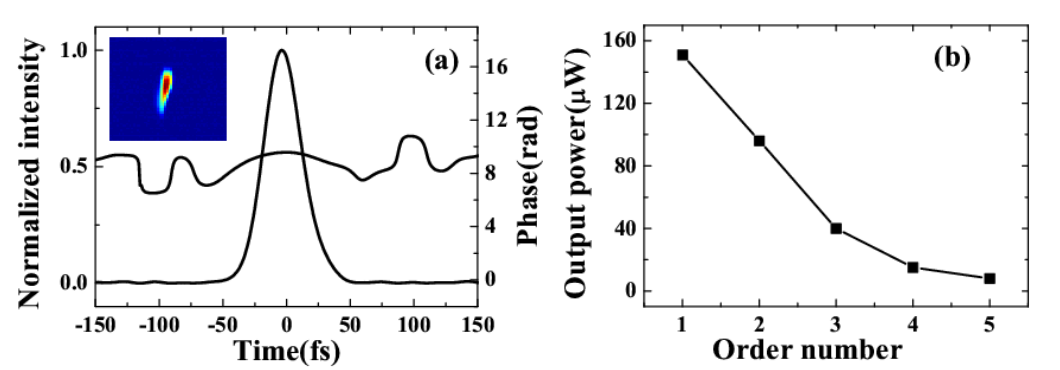
Figure 5. ( a) The XFROG retrieved trace of the temporal profile and phase of AS1. The pulse duration is about 35 fs. The inset is the measured XFROG pattern; (b) the output power of AS1 to AS5 when the input power of beam1 and beam2 were 11 and 19 mW, respectively, and the crossing angle was 1.8º